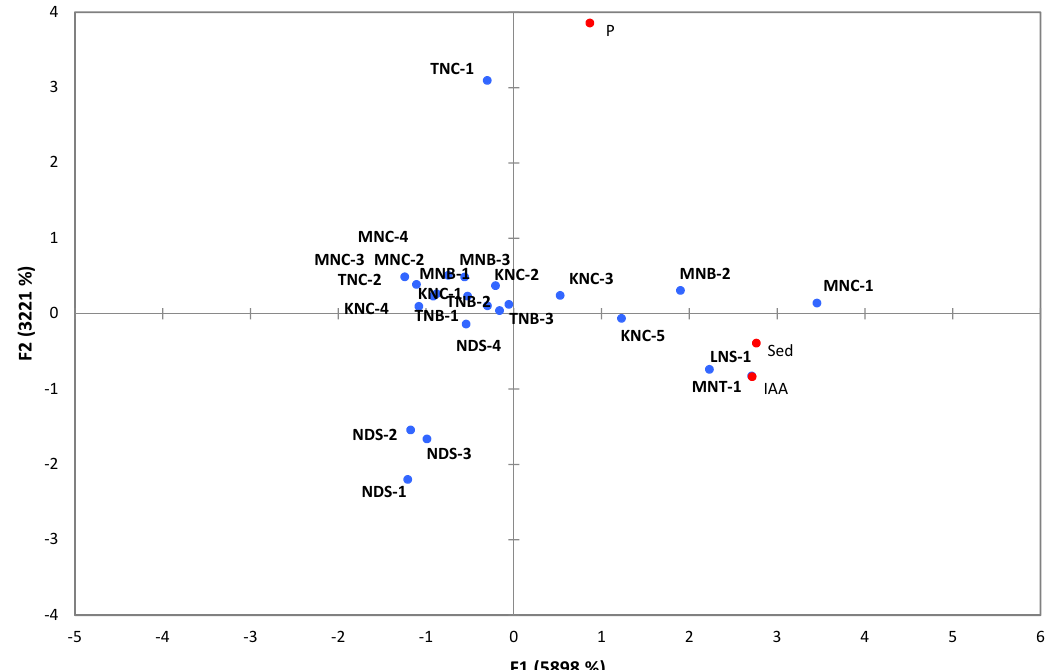
Figure 4. Principal coordinates analysis in term of phosphate solubilization (P), indole acetic acid (IAA) and siderophore (sid) production. The isolated actinobacteria are represented in blue; the PGP activities are presented in red.